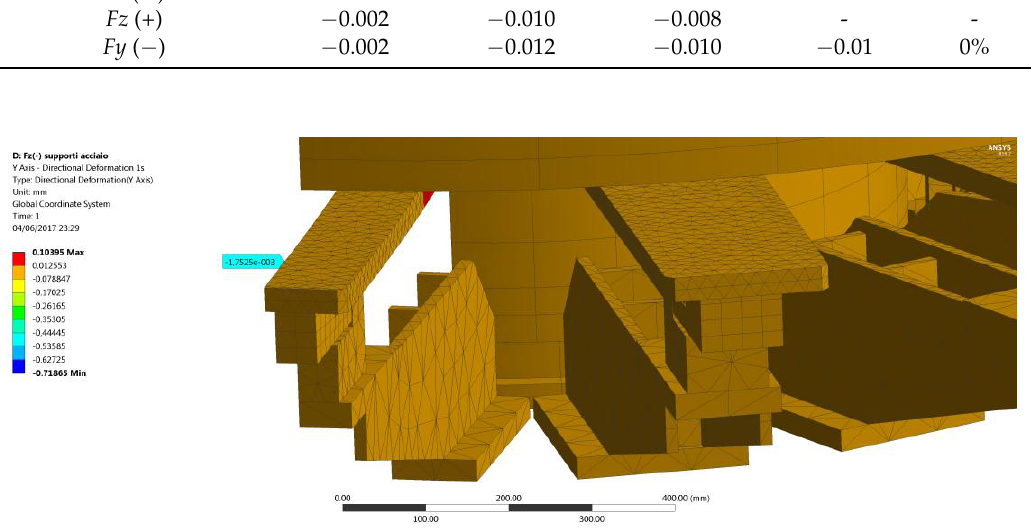
Figure 18. FE displacements of the Transfer Machine with 15 divisions after bolt preloading (scale factor 1000×).